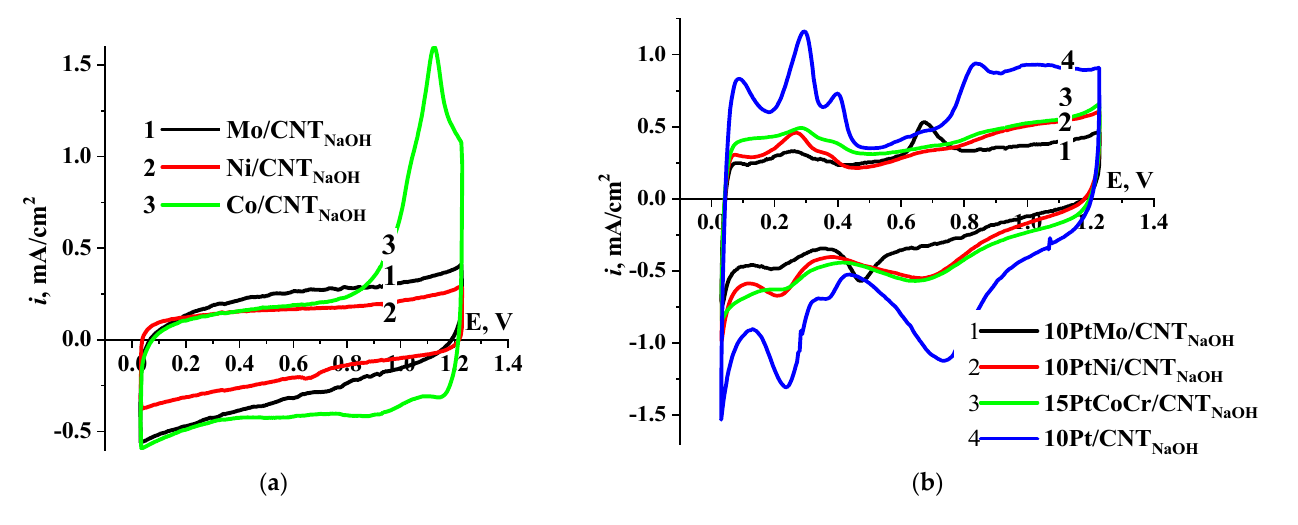
Figure 1. ( a ) CV for catalysts containing transition metals (shown in Figure); ( b ) CV for catalysts